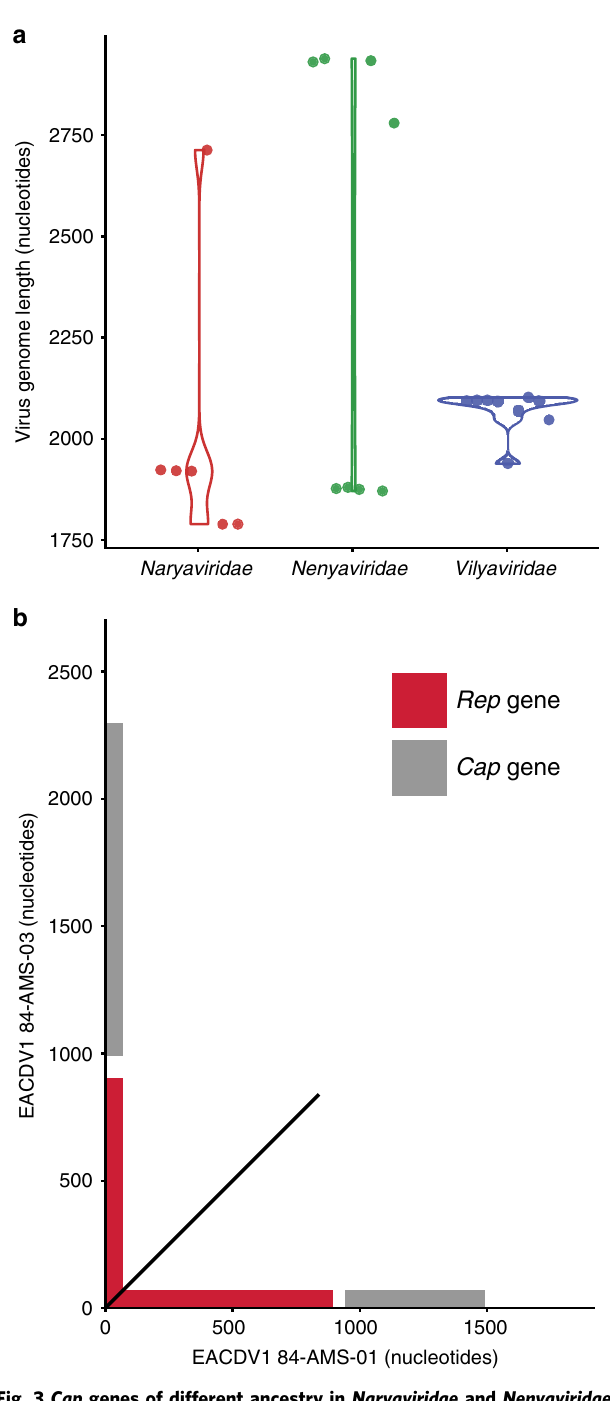
Fig. 3 Cap genes of different ancestry in Naryaviridae and Nenyaviridae . a Genome length variation in Naryaviridae , Nenyaviridae , and Vilyaviridae . Eighteen complete CRESS virus genomes identi fi ed in this study were plotted alongside fi ve complete publicly available genomes. b Dotplot of BLAT generated nucleotide alignment between a short and a long genome from the Naryaviridae , showing no detectable alignment between the Cap